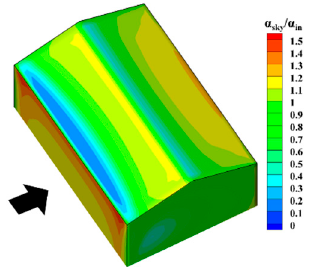
Figure 18. Normalized volume fraction of falling snow α sky / α in around the gable-roofed building.